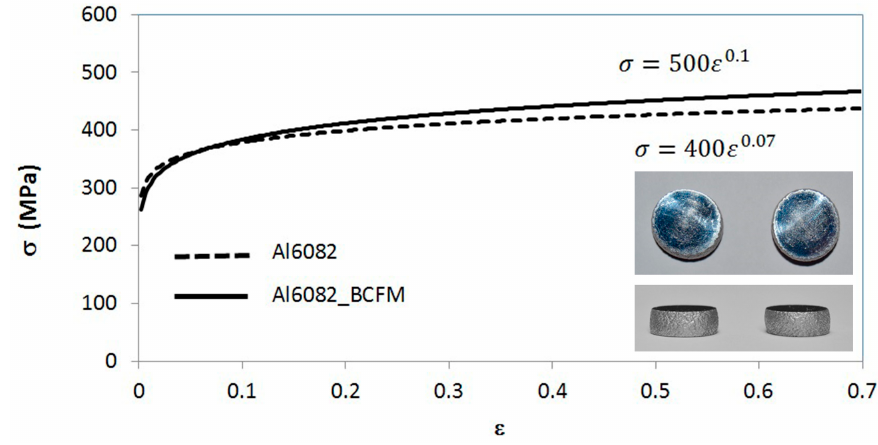
Figure 2. Plastic flow curve of the Aluminum alloy UNS A96082.